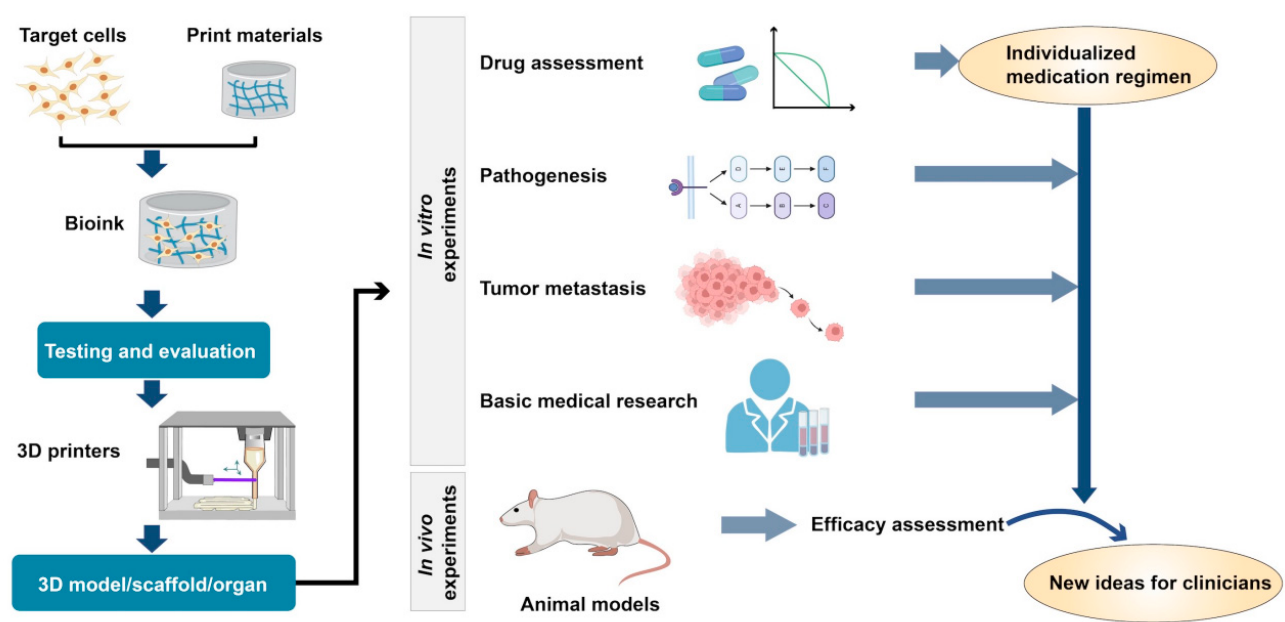
Figure 2. The process of 3D printing and application of tissue and organ models.